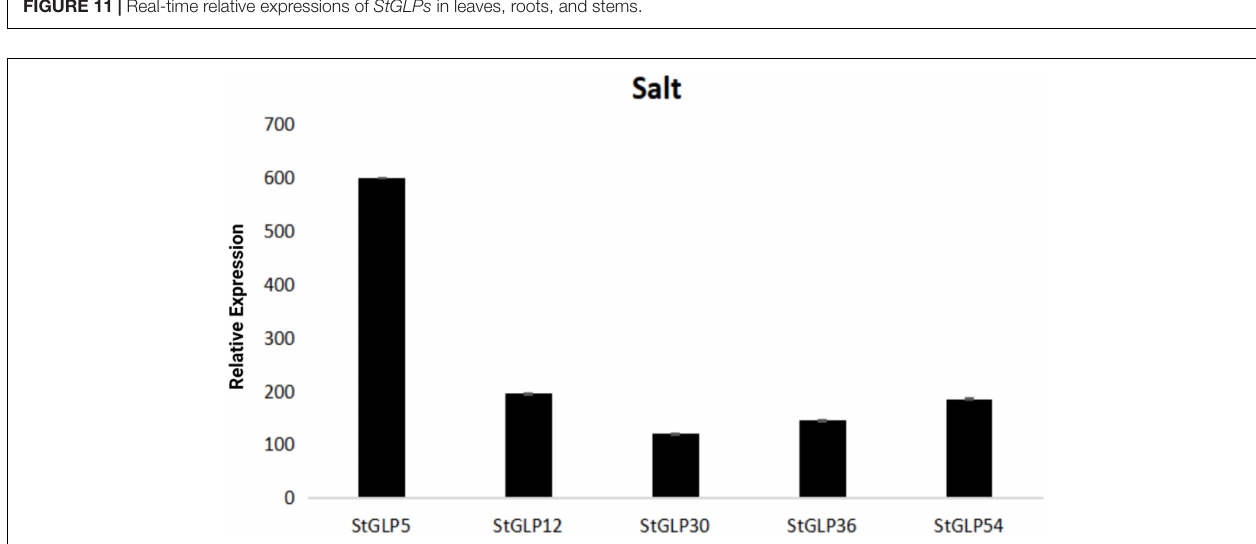
FIGURE 11 | Real-time relative expressions of StGLPs in leaves, roots, and stems.